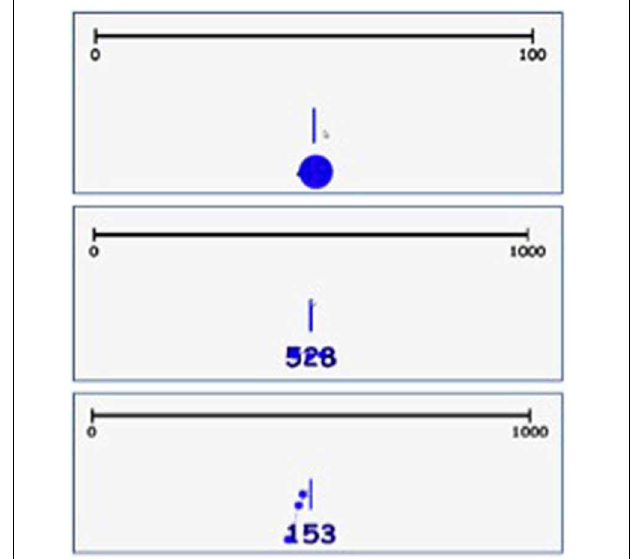
FIGURE 1 | Examples of the number processing strategies holistic (top), decomposed parallel (middle), and decomposed sequential